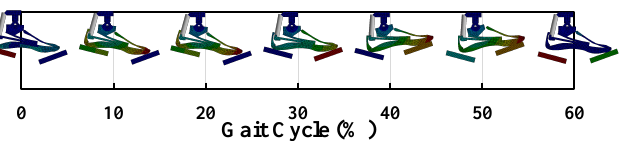
Figure 28. The deflection sequence of the 2D FE model of the prosthesis during ISO 10328 cyclic test. The foot prosthesis had its maximum plantarflexion around − 6.4° and maximum dorsiflexion around 15°. Both the values are comprised in the ranges specified in the Requirements section (Section 2.4), as also highlighted in Figure 29.